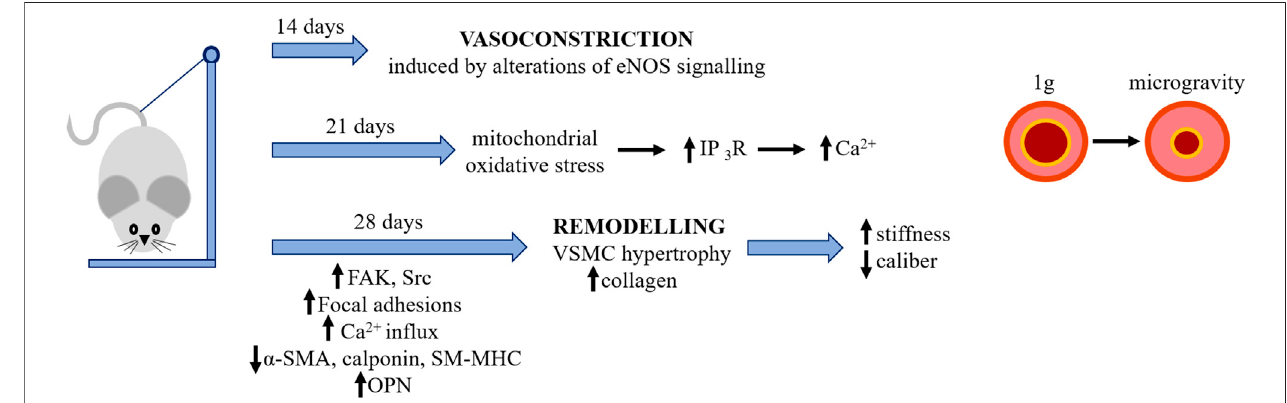
FIGURE3| Theeffects ofsimulatedmicrogravityonrodents ’ cerebralarteries.MicrogravitywassimulatedbyHU (seetext).Simulated microgravityinducesinitially vasoconstriction and then remodelling of rodents ’ cerebral arteries. IP 3 -R, inositol 1,4,5-trisphosphate receptor; FAK, focal adhesion kinase; α -SMA, alpha-smooth muscle actin; SM-MHC, smooth muscle-myosin heavy chain; OPN,